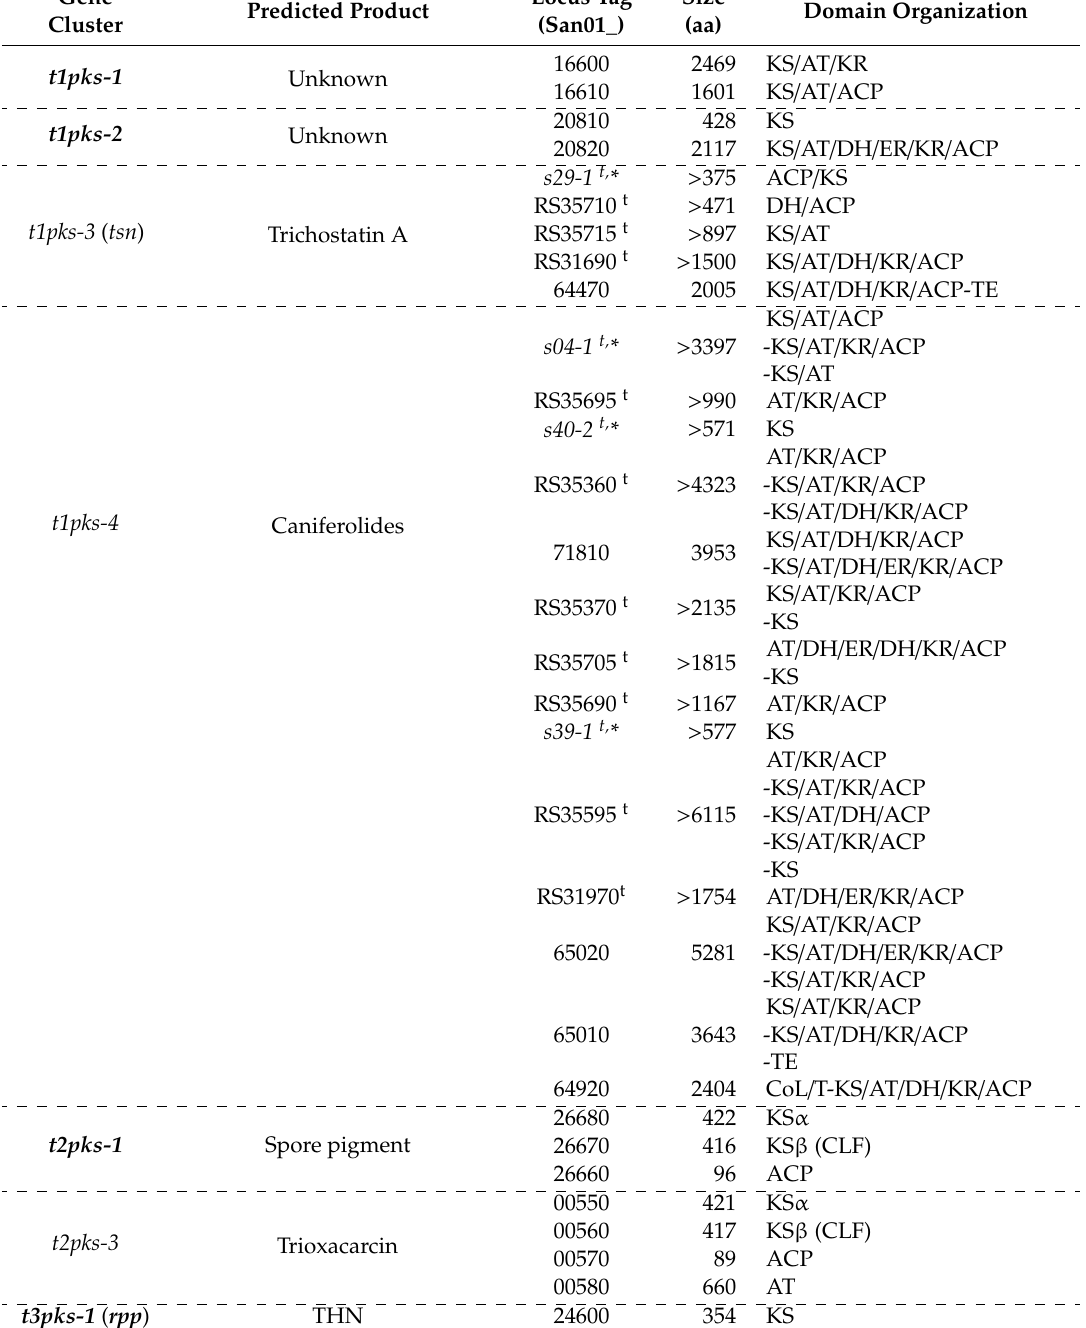
Table 4. PKS and NRPS in the gene clusters of S. angustmyceticus NBRC 3934 T